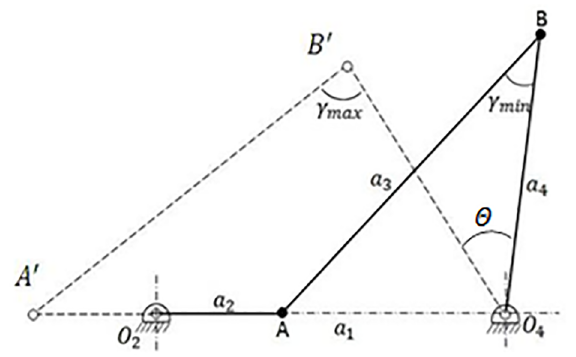
Figure 3. Four-bar mechanism at max. and min. transmission an- gles.